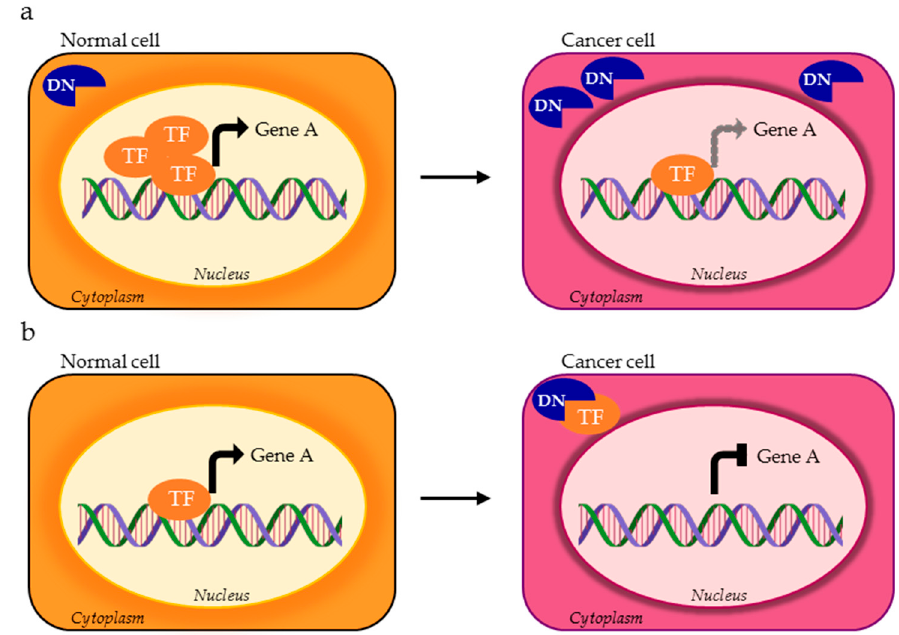
Figure 3. AS isoform of a TF can be mislocalized within cancer cell and exert a dominant negative (DN) activity as the consequence of ( a ) excessive expression of the non functional isoform (blue DN) compared to the functional one (orange TF) or ( b ) cytoplasmic titration of the functional TF variant.